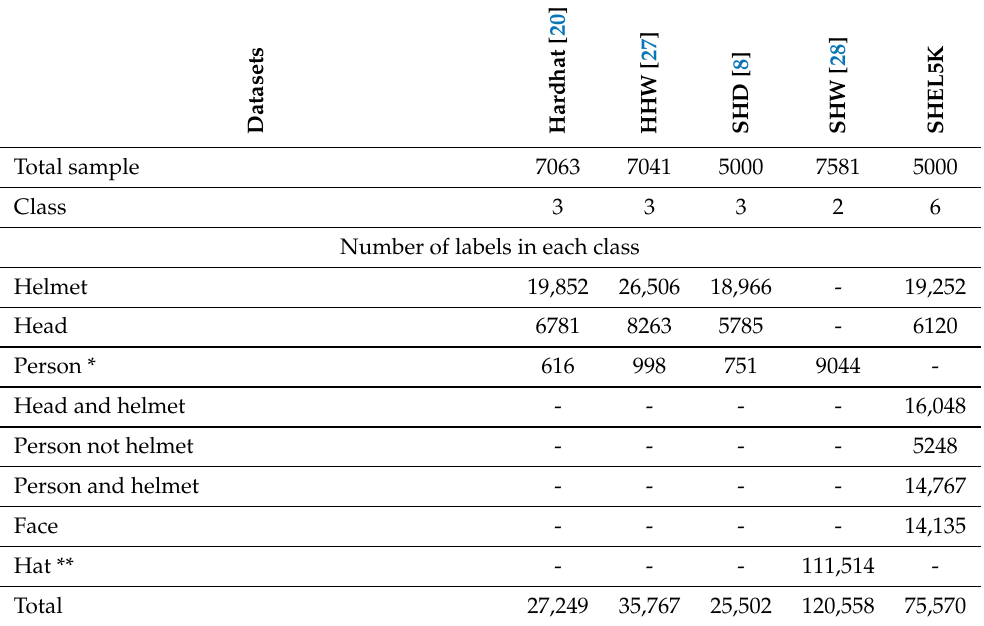
Table 1. Comparison of public safety helmet datasets and the SHEL5K